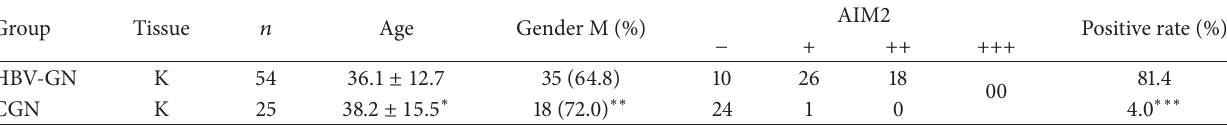
Table 2: AIM2 expression in HBV-GN and CGN.